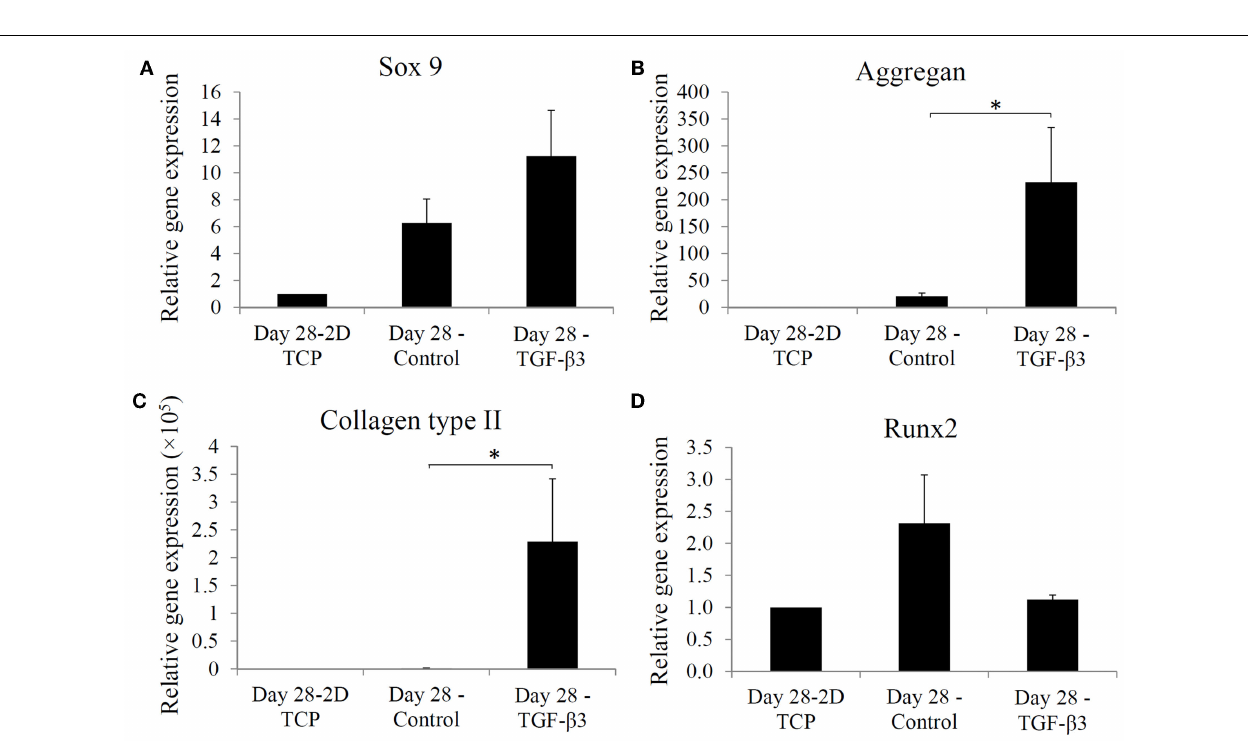
be uniformly distributed at different layers. (I) Based on live/dead staining results, cell viability at days 0 and 28 in control as well as TGF- β 3 group was calculated. (J) MTS assay of constructs at days 0 and 28 in control as well as TGF- β 3 group. Scale bars: (A) 1mm; (B) 500 μ m; and (C–H) 100 μ m. * p < 0.05.